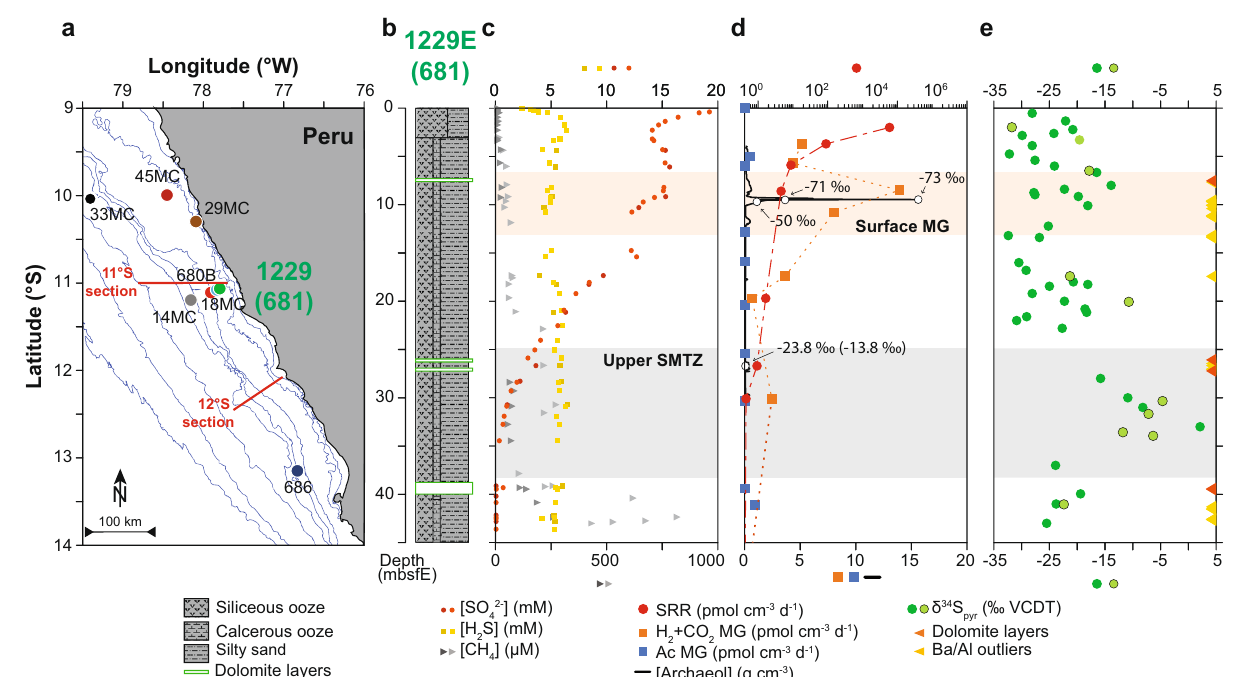
Fig. 1 Geography and stratigraphy of the study site. a Geographic location map of samples investigated in this study. Location of the Ocean Drilling Program (ODP) site 1229 (green dot) and other cores mentioned in this study. b Stratigraphic section of hole 1229E. Redrawn from ref. 46 . c Depth pro fi les of porewater sulfate (mM), sul fi de (mM), and methane ( μ M) concentrations. Dark and light symbols refer to site 1229 hole A and D, respectively. d Sulfate reduction rate (SRR, in pmol cm – 3 d – 1 ), hydrogenotrophic methanogenesis rate (H 2 + CO 2 MG, in pmol cm – 3 d – 1 ), and acetoclastic methanogenesis rate (Ac MG, in pmol cm – 3 d – 1 ; from ref. 25 ), archaeol concentration (g cm – 3 ; from ref. 26,27 ). e δ 34 S values preserved in sedimentary pyrite, as measured in this study (dark green dots) and in ref. 28 (light green dots), and location of dolomite layers (from ref. 35 ) and barite layers (based on Ba/Al ratios). Both near- surface methanogenesis (surface MG; orange band) and the sulfate − methane transition zone (SMTZ, gray band) are